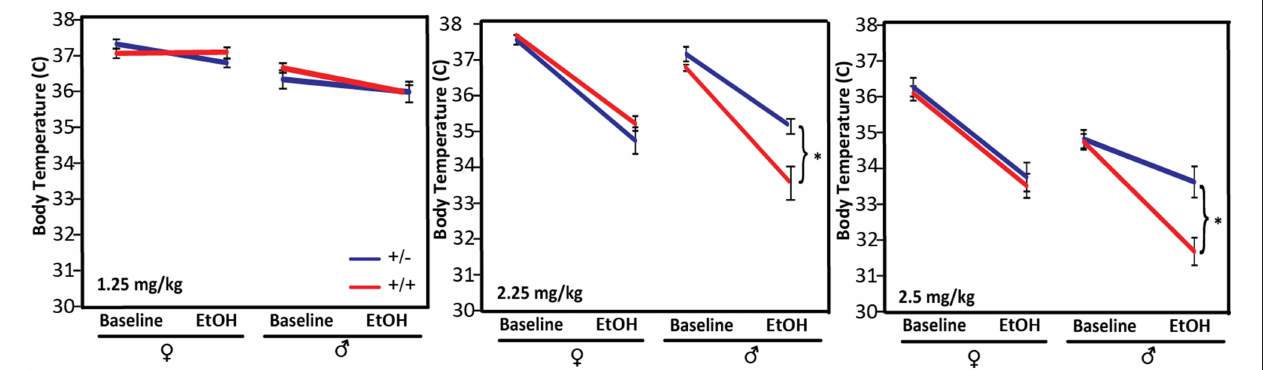
FIGURE 3 | Hypothermic response to different doses of ethanol, 1.25, 2.25, and 2.5g/kg. Means ± SEM are depicted for 1.25g/kg (8 ± ♀ , 10 ± ♂ , 11 + / + ♀ , 11 + / + ♂ ), 2.25, and 2.5g/kg (10 ± ♀ , 6 ± ♂ , 10 + / + ♀ , 3 + / + ♂ ). * p < 0.05 .